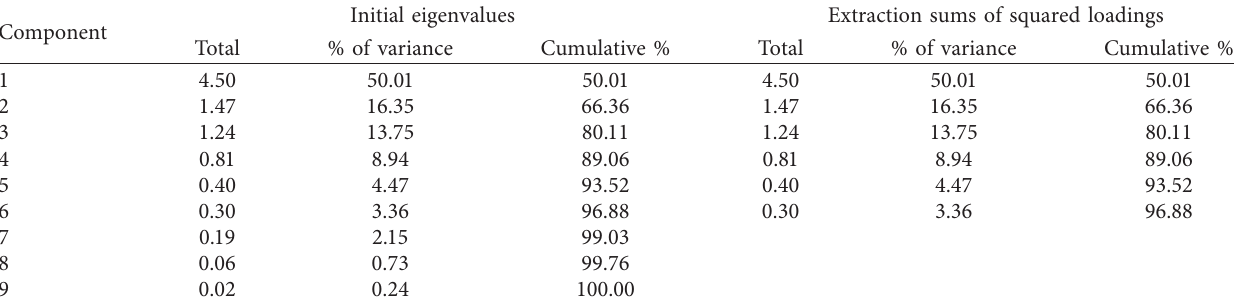
Table 7: Total variance explained.